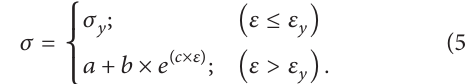
exponential function. The cyclic hardening coefficient 𝐾 󸀠 and the cyclic hardening exponent 𝑛 󸀠 reflect the degree of the hardening of steel under cyclic loading